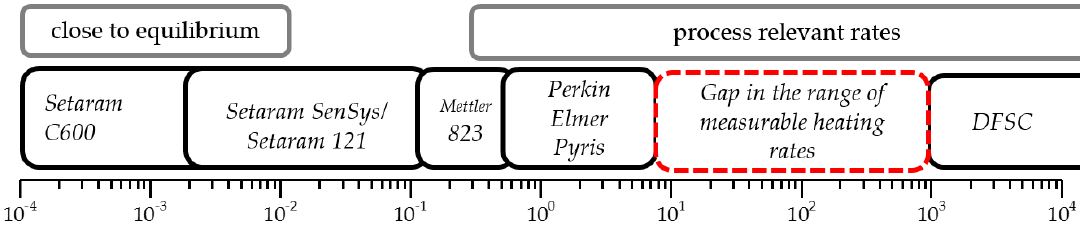
Figure 1. Scanning rate range of different conventional differential scanning calorimetry (DSC) devices and non-conventional fast scanning calorimeters.